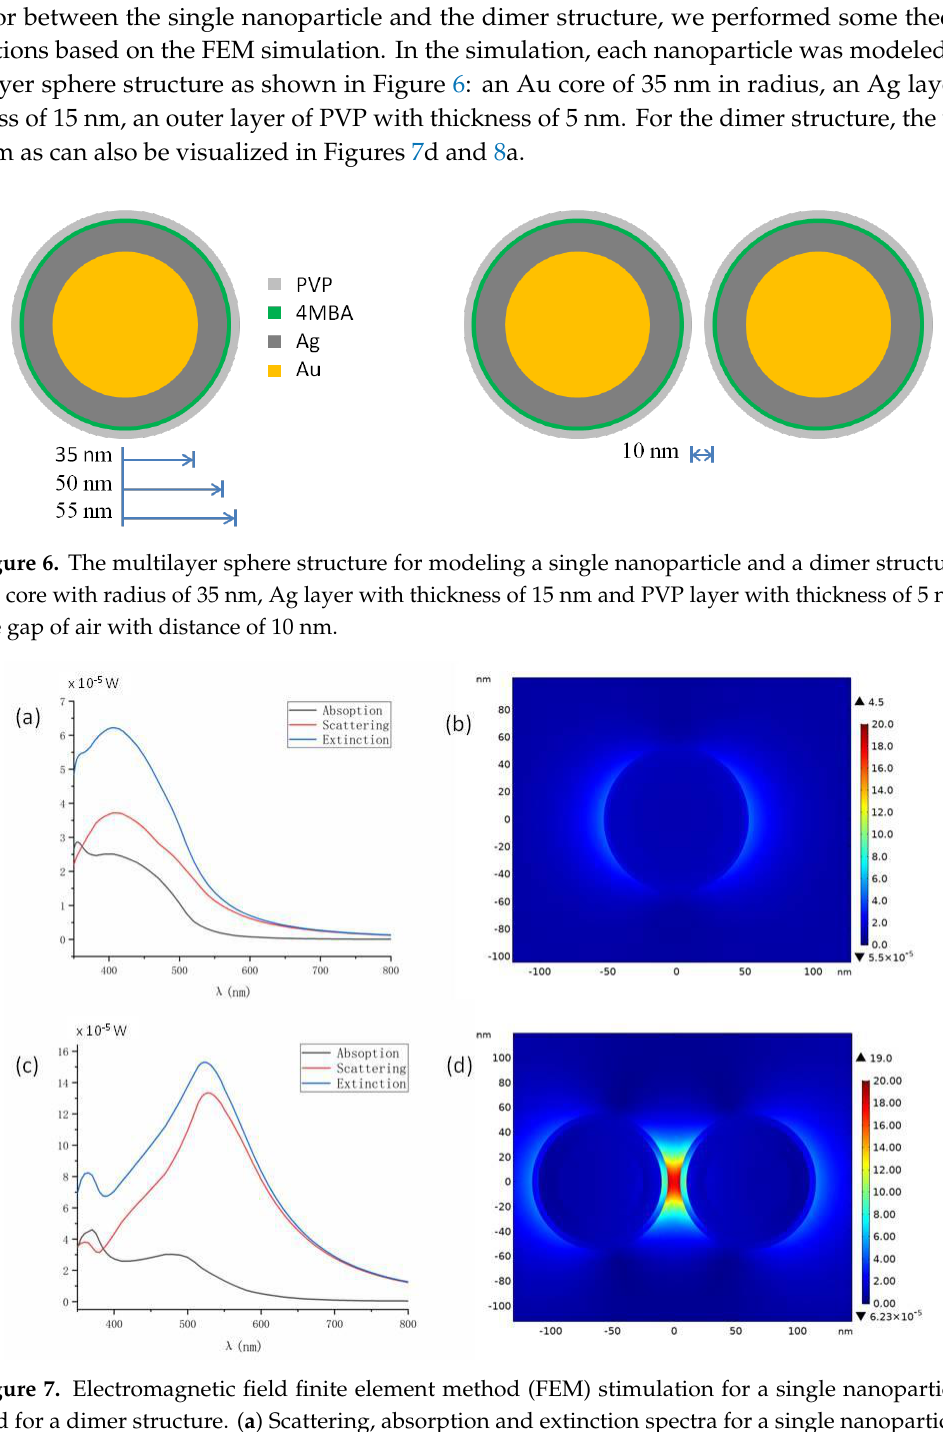
Figure 5. SERS spectra of a dimer structure measured continually at the fixed laser power setting of 0.8 mW (with the time order from black curve, next red curve, then blue curve).